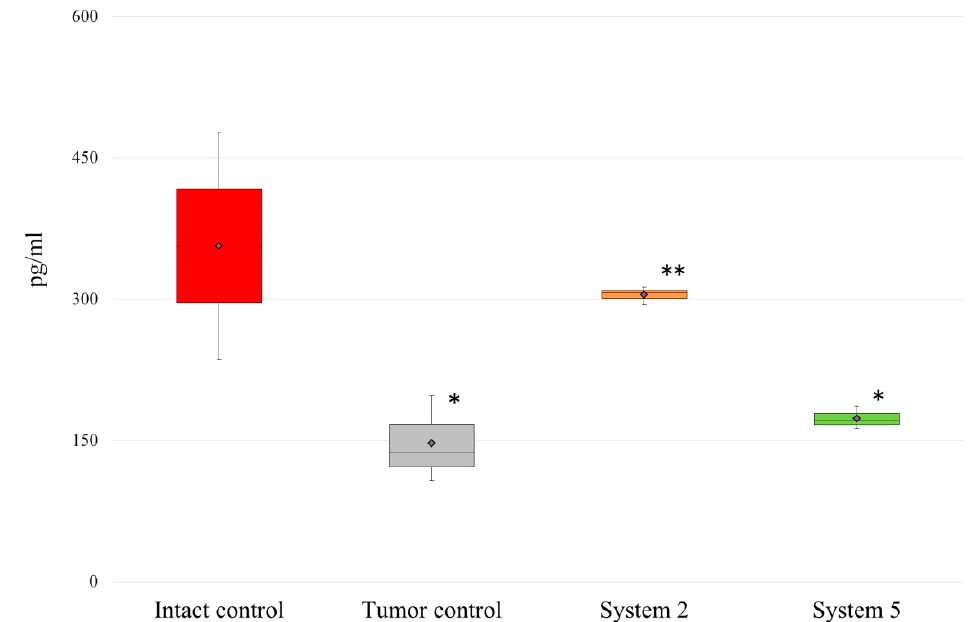
Figure 3. Changes in IL-17 concentration in response to administration of the polymeric systems. Rats were administered i.p. with 9 mg/kg polymeric system (System 2 or System 5) once on the 10th day, which corresponded to the beginning of oncogenesis and formation of tumor nodes, and the activation of the immune system. Control rats received PBS. Results are representative of four independent assays and show the Median (Me) with interquartile range (25th percentile; 75th percentile) of triplicate determinations for one of four experiments. Differences from (*) intact rats or (**) control tumor-bearing rats were significant at p < 0.05.